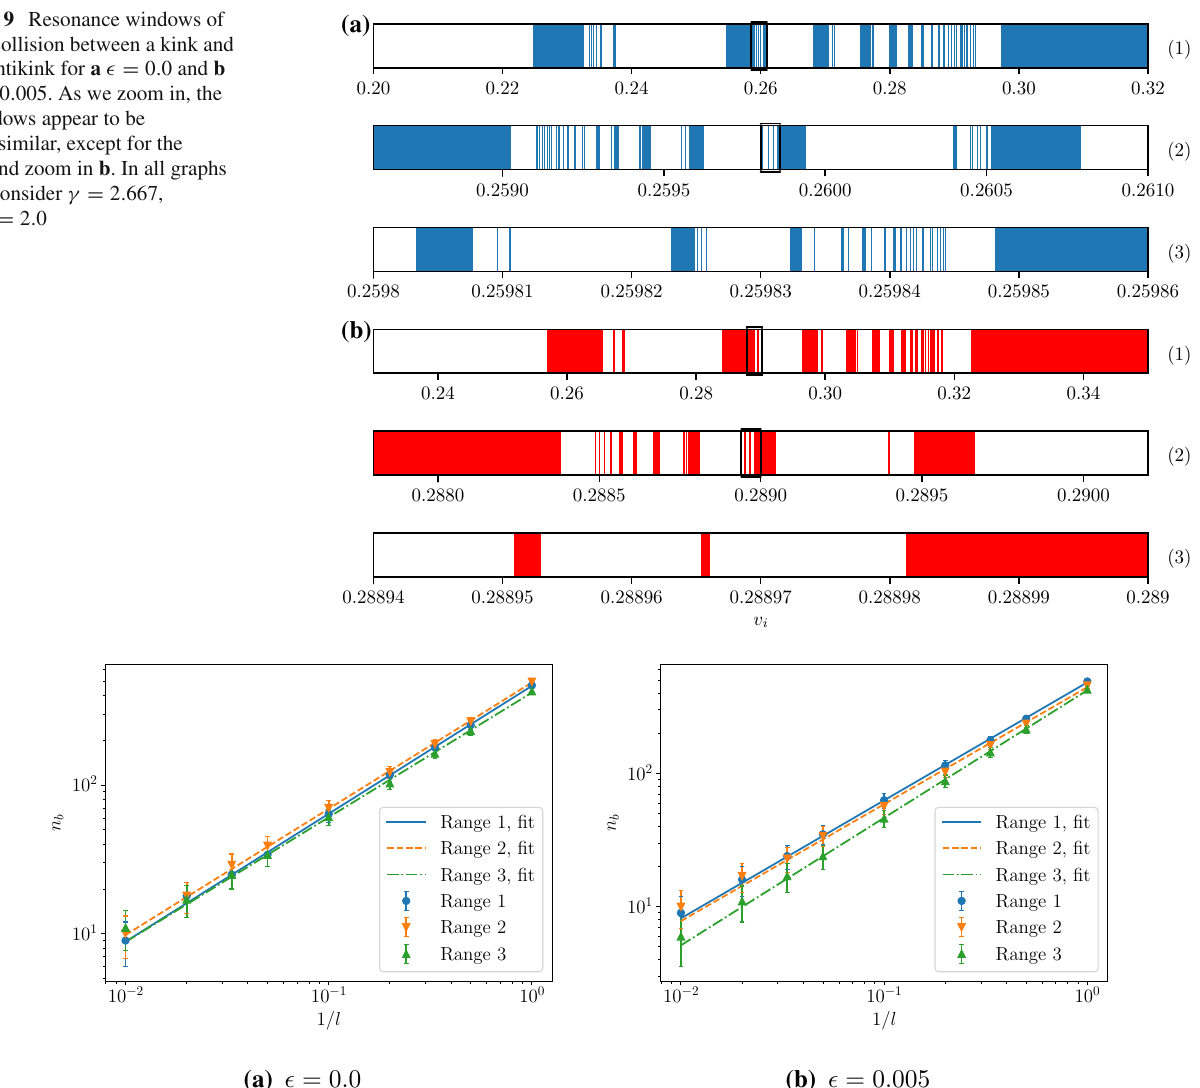
Fig. 10 Number of boxes to cover the set of resonance windows intervals shown in Fig. 9 versus the inverse of the size of the boxes in log scale. The box lengths are rescaled to lie in the same range. Parameters are γ = 2 . 667 and (cid:8)γ = 2 . 0 Table 2 Slope of n b as a function of 1 / l (inverse of the box length) in log scale for three different ranges in v i for two values (cid:9) = 0 . 0 and (cid:9) = 0 . 005. Each range is divided up to maximum 1200 boxes